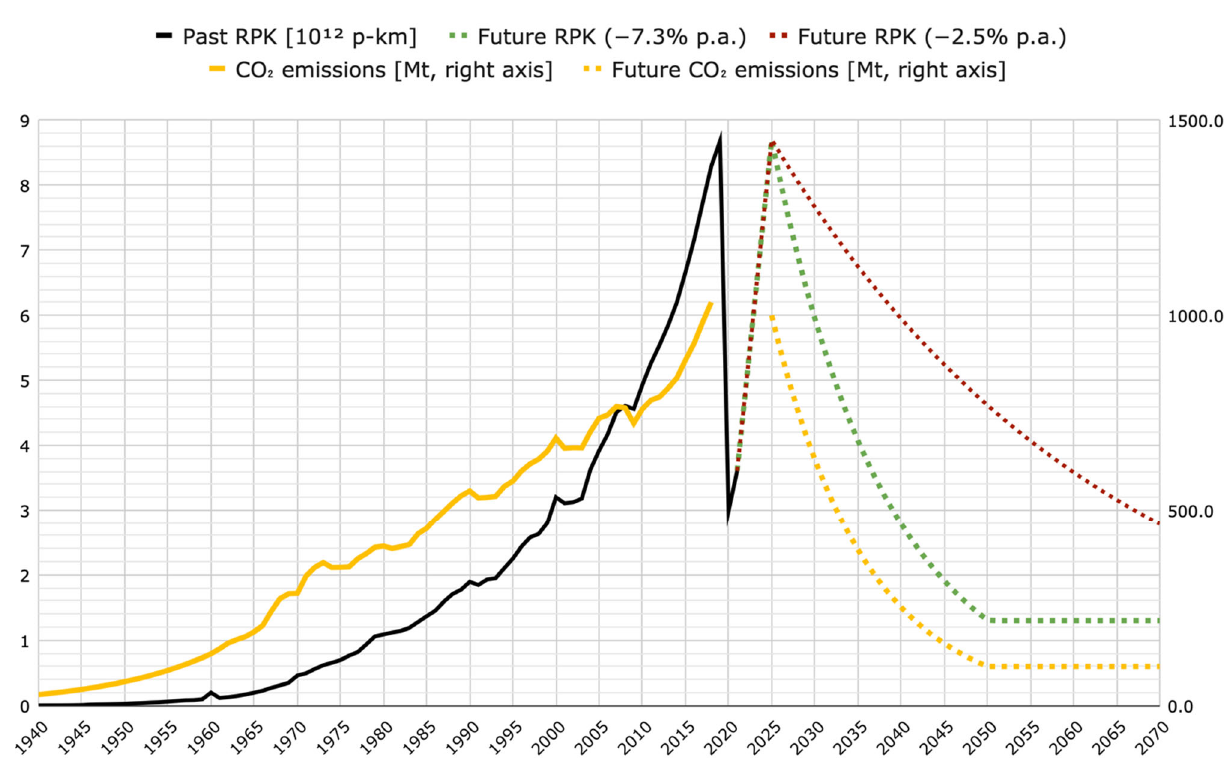
Figure 1. Revenue passenger-km (Ritchie et al. 2020; Airlines for America 2022) (black) and CO 2 emissions (Sausen and Schumann 2000; Lee et al. 2021) (yellow, right axis); future developments of RPK and CO 2 are discussed in Section 3 (dotted lines).